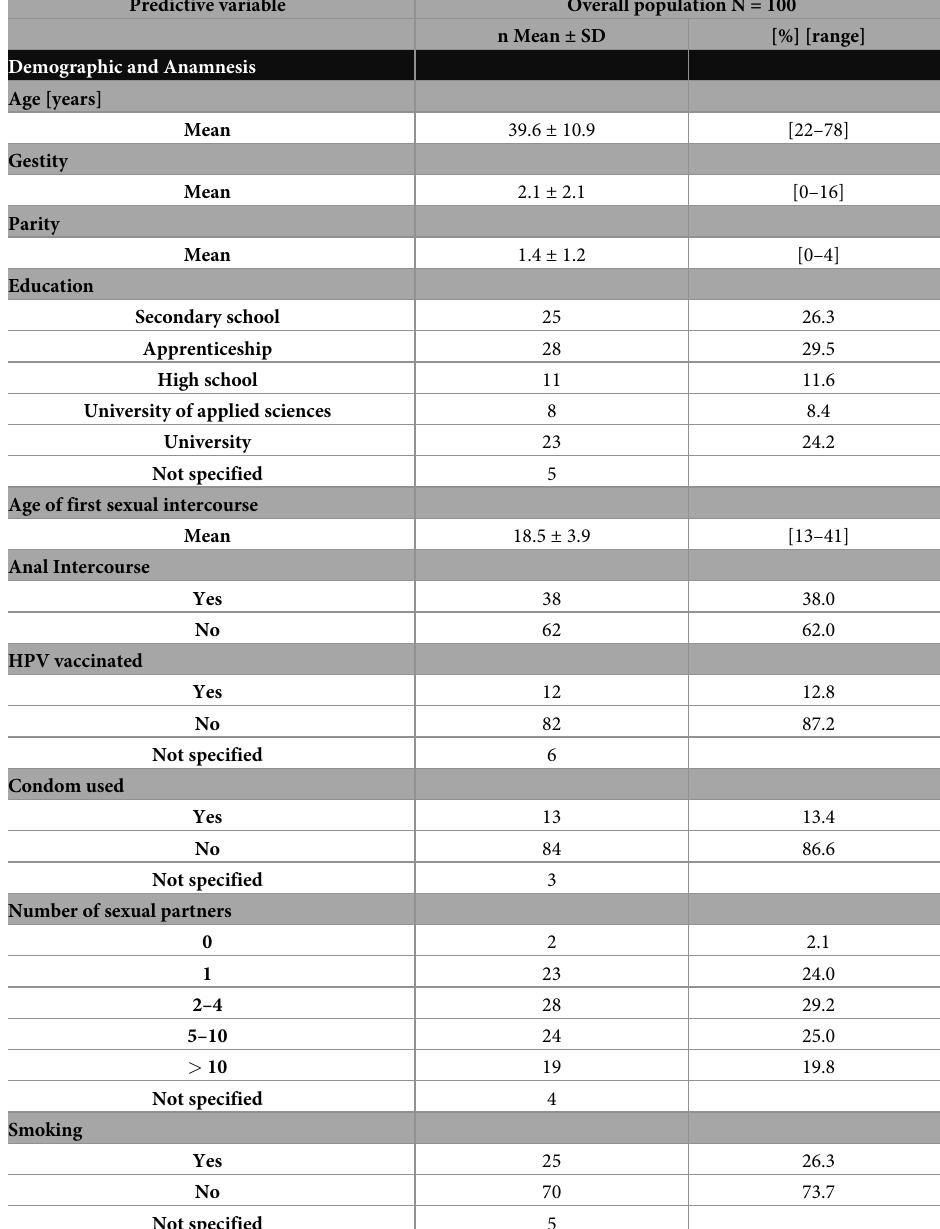
Table 1. Patient